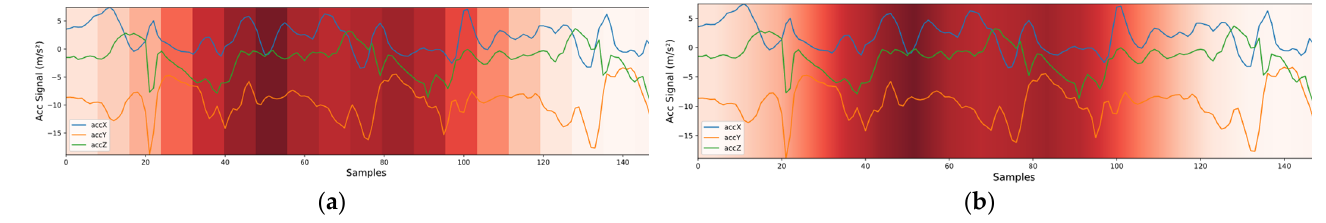
Figure 1. Comparison of nearest-neighbor and bilinear interpolation methods. ( a ) Nearest-neighbor interpolation. ( b ) Bilinear interpolation.